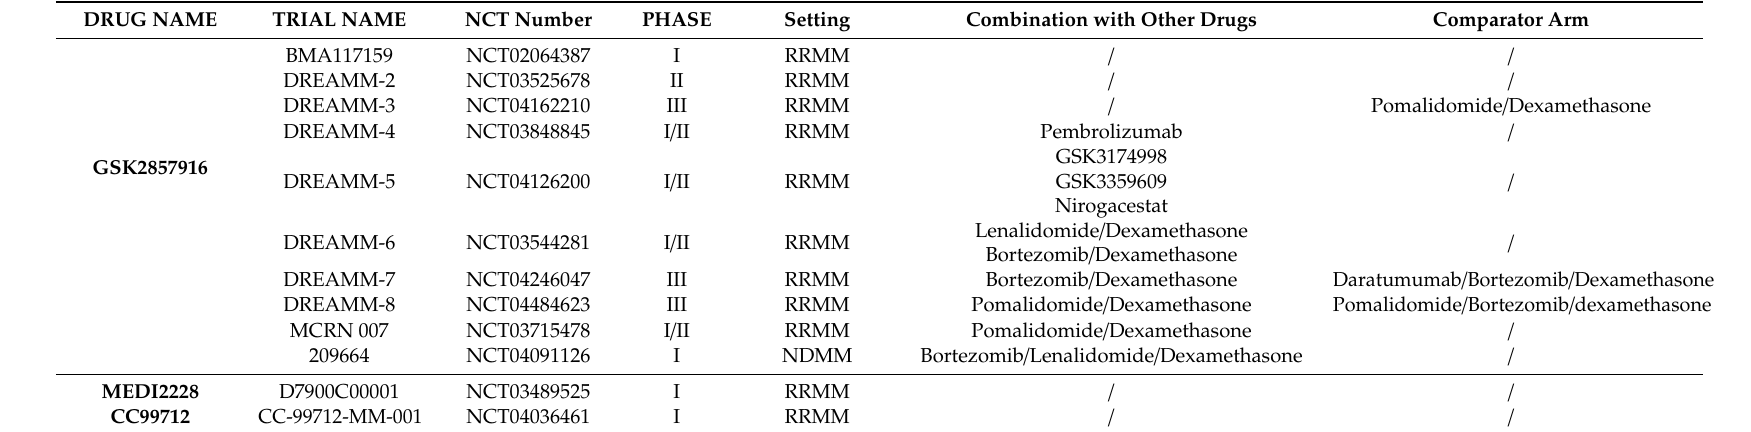
Table 2. Ongoing clinical trials with BCMA antibody-drug